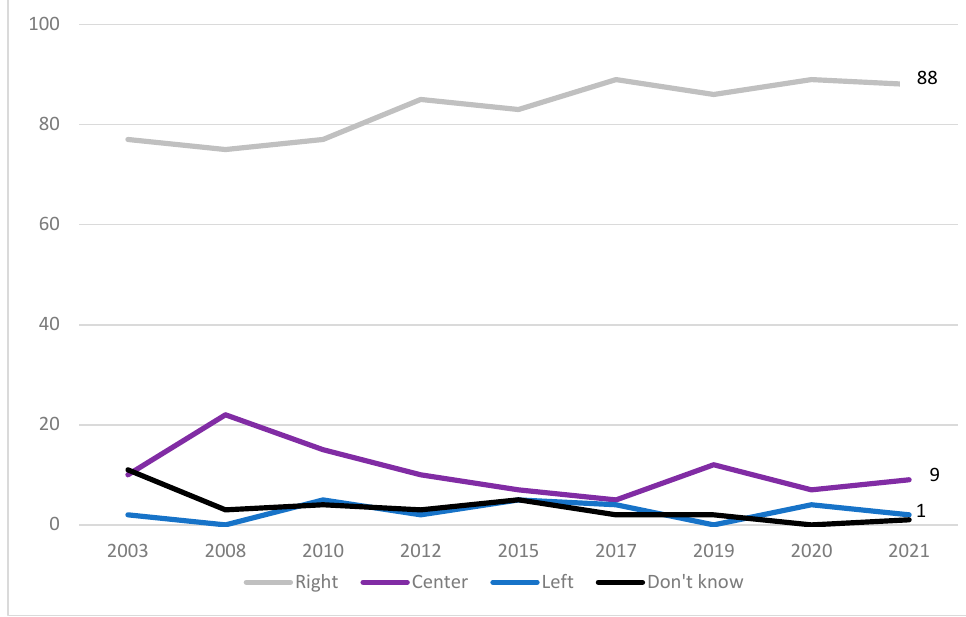
Figure 2. RZS political self-positioning, 2003 ‒ 2021 (%) (Source: Israeli Democracy Index, 2003 ‒ 2021). Third, the RZS has undergone a substantial change in aspirations since the 1970s.